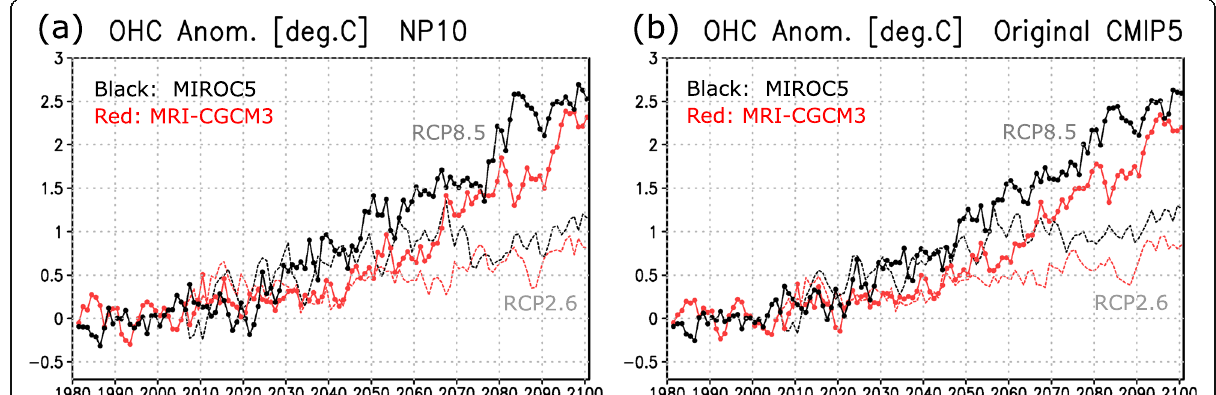
Fig. 7 a Transitions (1981 – 2100) of the OHC anomalies (°C) against the 1986 – 2005 mean for the area surrounding Japan (123° E – 150° E, 24° N – 47° N) from the NP10 results. Black, MIROC5; red, MRI-CGCM3; thick solid line, historical + RCP8.5; thin dotted line, RCP2.6. b The same as ( a ), but using the corresponding original CMIP5 ocean